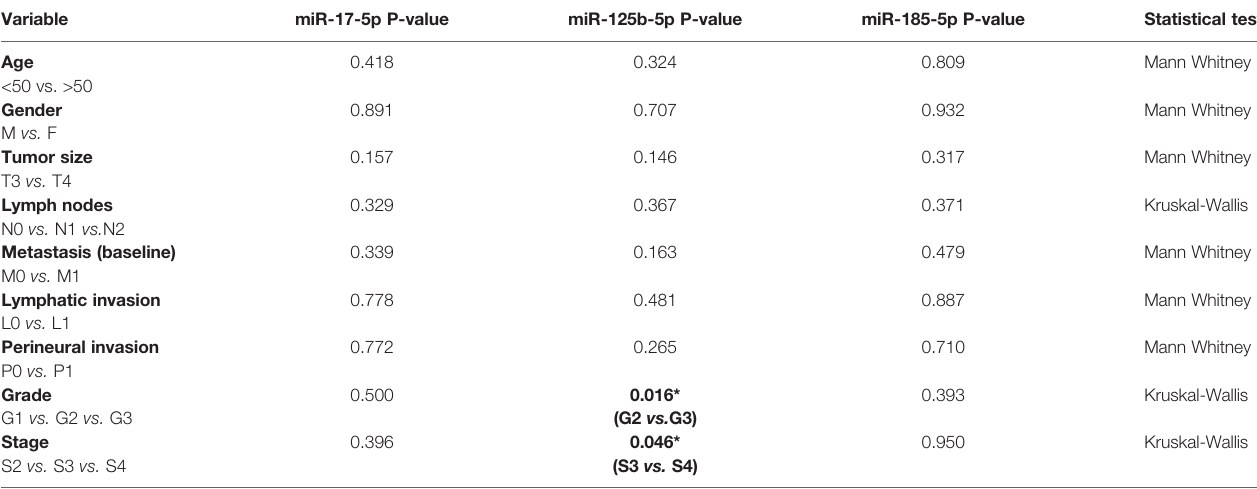
TABLE 5 | Signi fi cant differences between miRNAs with clinical data in the studied plasma samples. Variable miR-17-5p P-value miR-125b-5p P-value miR-185-5p P-value Statistical test Age <50 vs.